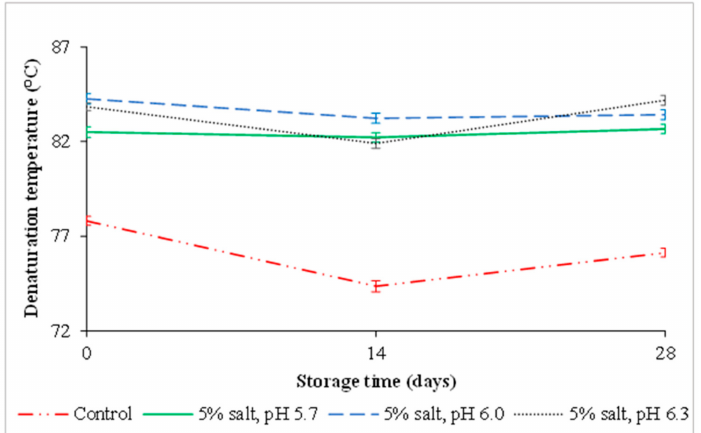
Figure 8. The effect of treatment on the denaturation temperature of frozen-thawed liquid egg yolk. Data are presented with mean ± standard